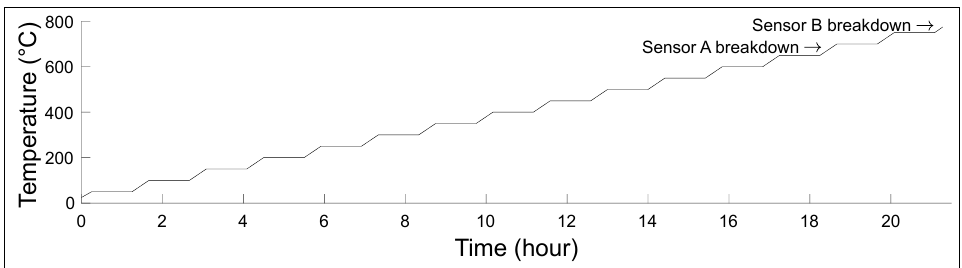
Figure 3. Transducers A and B from room temperature to 750 ◦ C